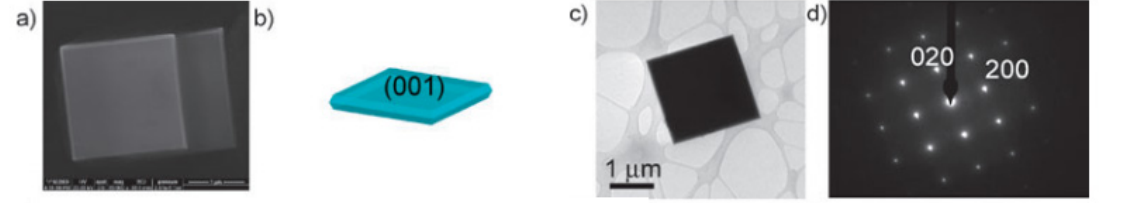
Figure 3. Field emission scanning electron microscope (FESEM) image ( a ), simulated model ( b ), TEM image of a representative anatase single crystal recorded along the (001) axis ( c ), selected area electron diffraction (SAED) pattern and ( d ) high resolution transmission electron microscope (HRTEM) image [59]. Copyright Royal Society of Chemistry, 2009.